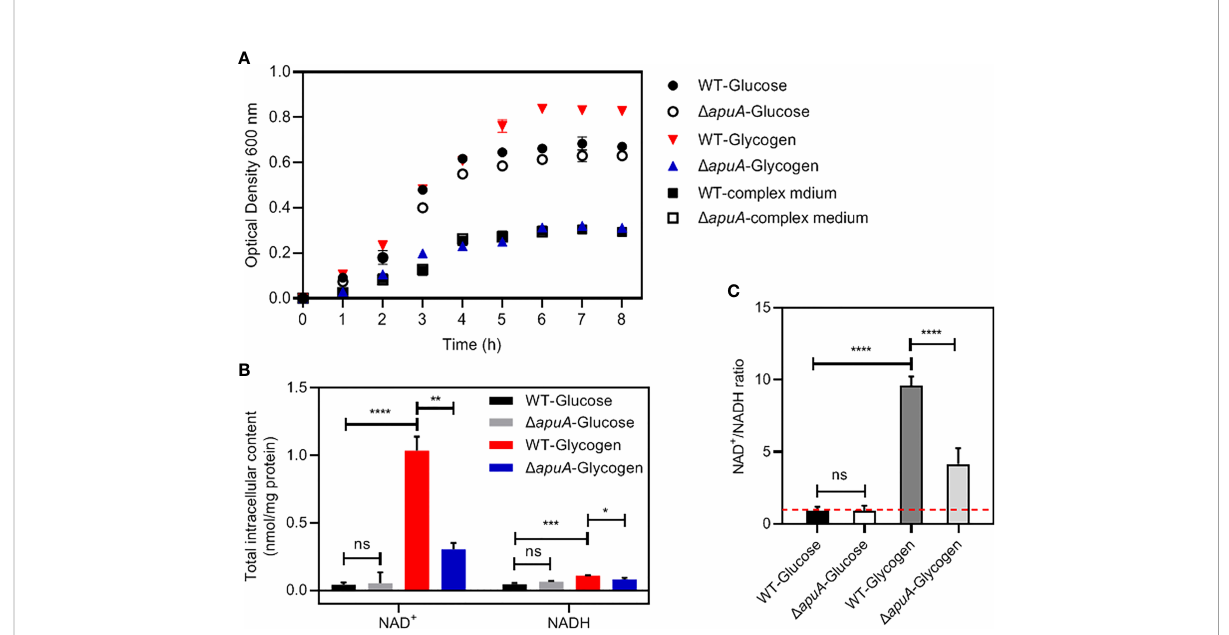
FIGURE 5 Different characteristics of WT and D apuA treated with different media. (A) Growth curves. Strains were grown in different media at 37°C. The turbidity of cultures was measured at 1 h intervals. (B) The total intracellular content of NAD + and NADH. Data was presented as mean ± SEM. (C) The NAD + /NADH ratio. The total intracellular NAD + /NADH ratio was presented as mean ± SEM. The red dotted line in the histogram indicates the NAD + /NADH ratio of 1. Statistical signi fi cance was determined using unpaired Student ’ s t tests (ns, P > 0.05; *, P < 0.05; **, P < 0.01; ***, P < 0.001; ****, P <